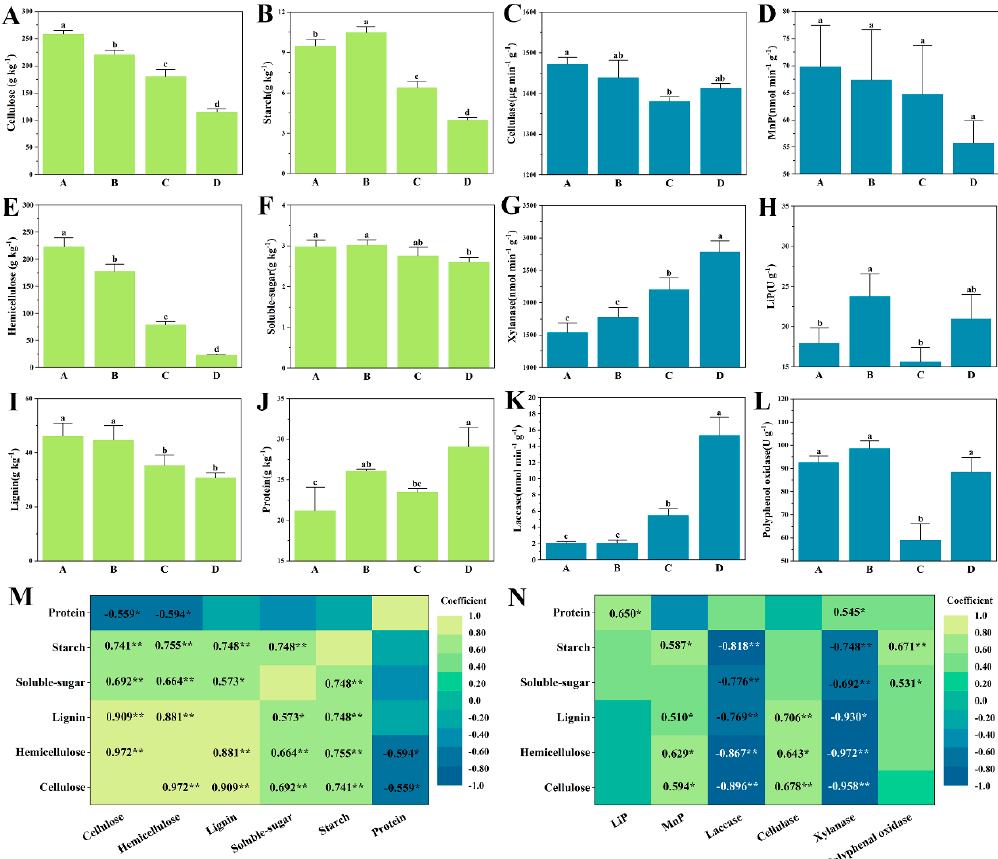
Figure 1. The variation of carbon sources and enzyme activities. ( A – L ) depicts the variation of carbon sources and enzyme activities during four stages, different letters a, b, c and d indicate significant differences at p < 0.05 level (Turkey’s HSD). ( M , N ) depict the Spearman correlation heatmaps of carbon sources and enzyme activities, * indicates significant correlated at p < 0.05 level and ** p < 0.01 level, blue indicates negatively correlated while yellow positively. The LiP and MnP are abbreviations for lignin peroxidase and manganese peroxidase, respectively.